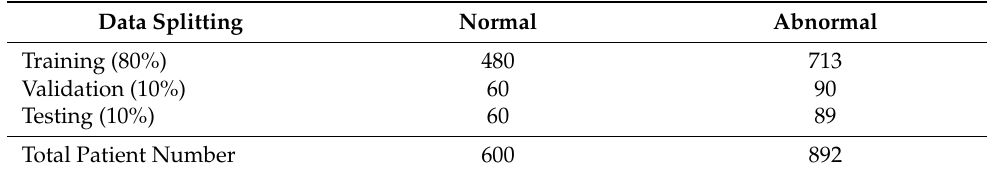
Table 1. Scenario A (binary Classification) data splitting training, validation, and testing. Data Splitting